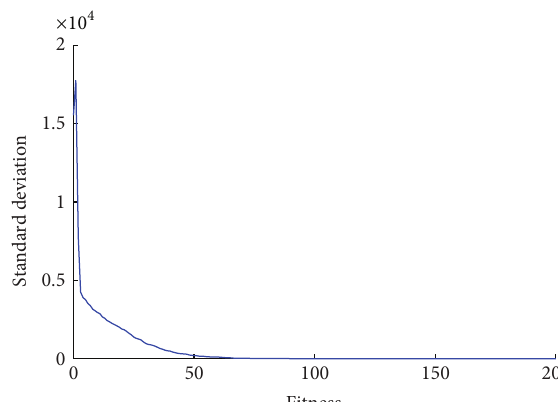
Figure 9: Standard deviation of the population fitness.